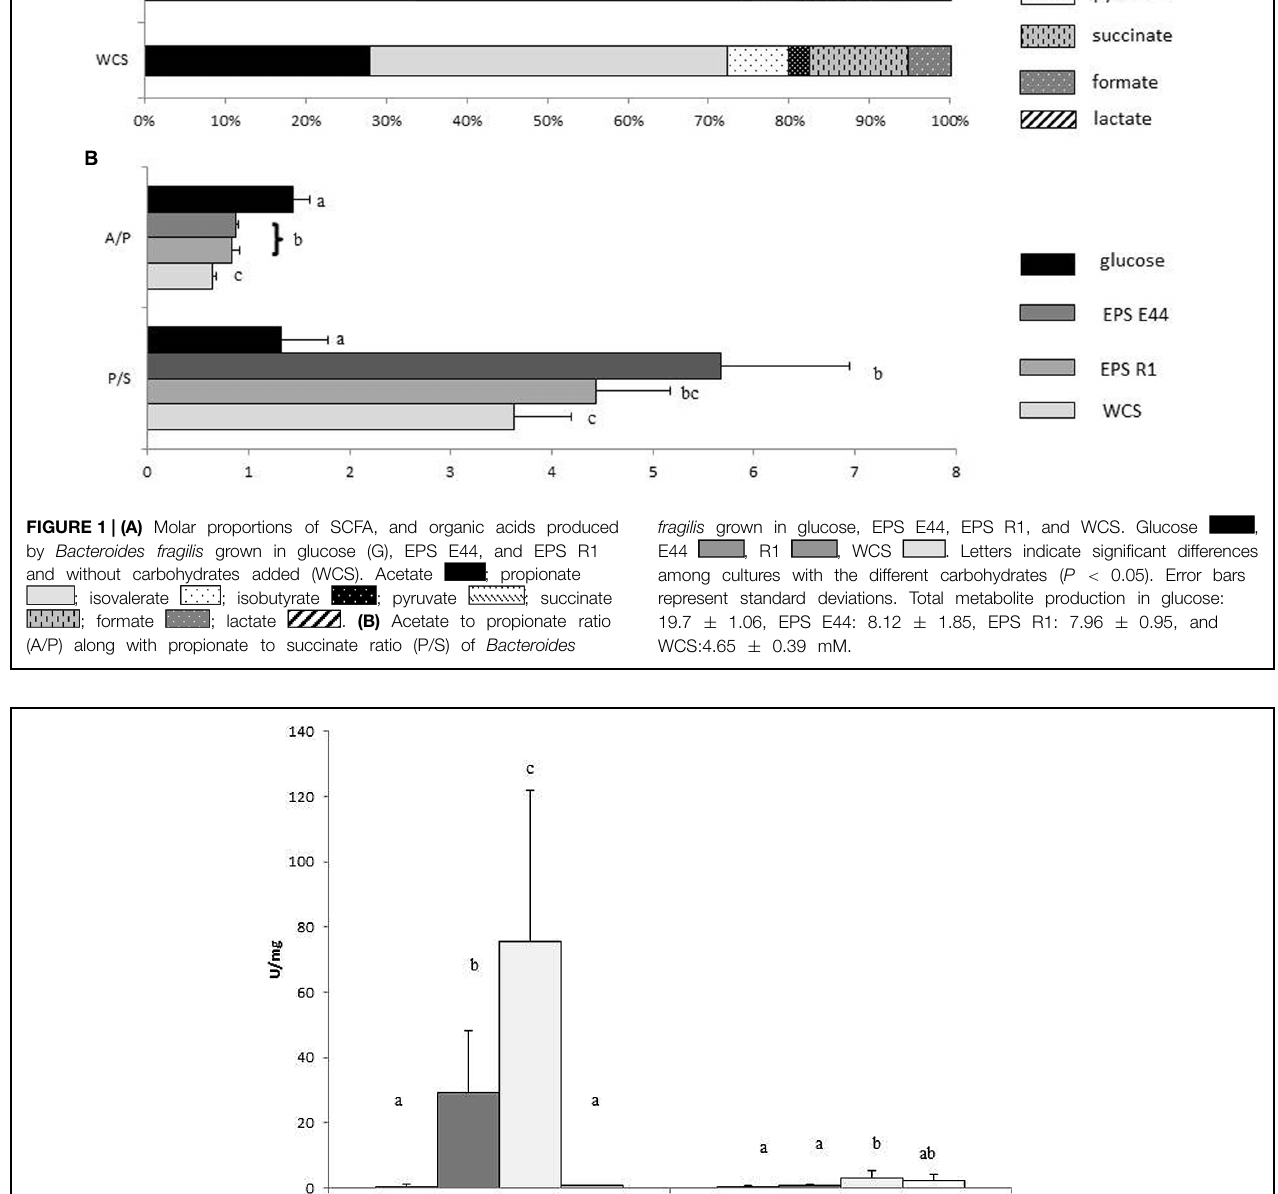
to the amount of protein present in 1 mL of cell culture and expressed as U/mg protein. Different letters indicate significant differences among cultures with the different carbohydrates ( P < 0.05). Error bars represent standard deviation.